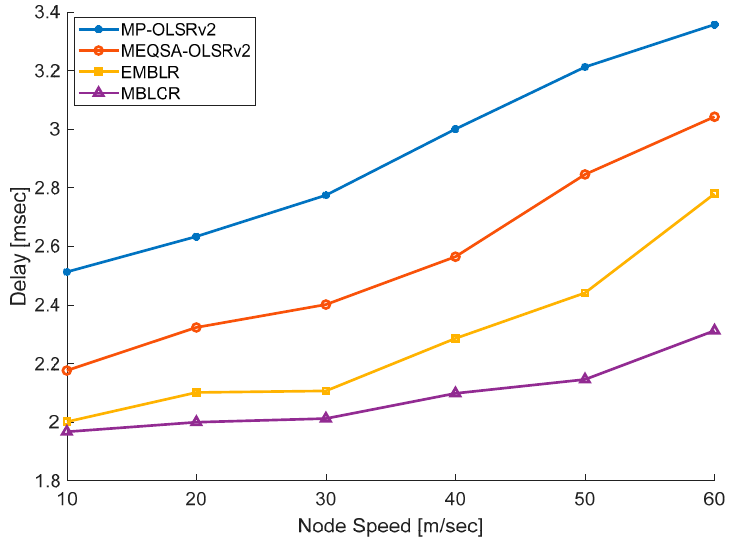
Figure 6. End-to-end delay with various devices speeds.